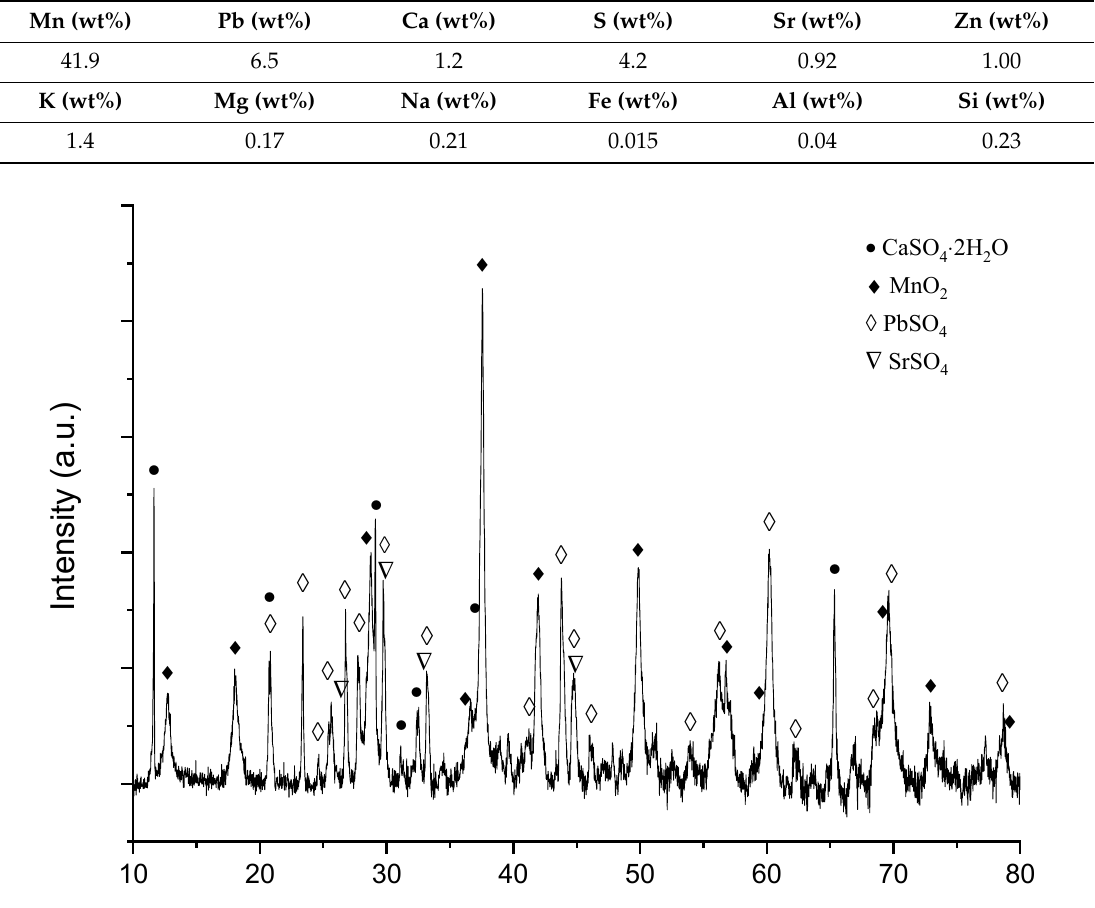
Table 1. Average chemical composition of the main elements in anode sludge.